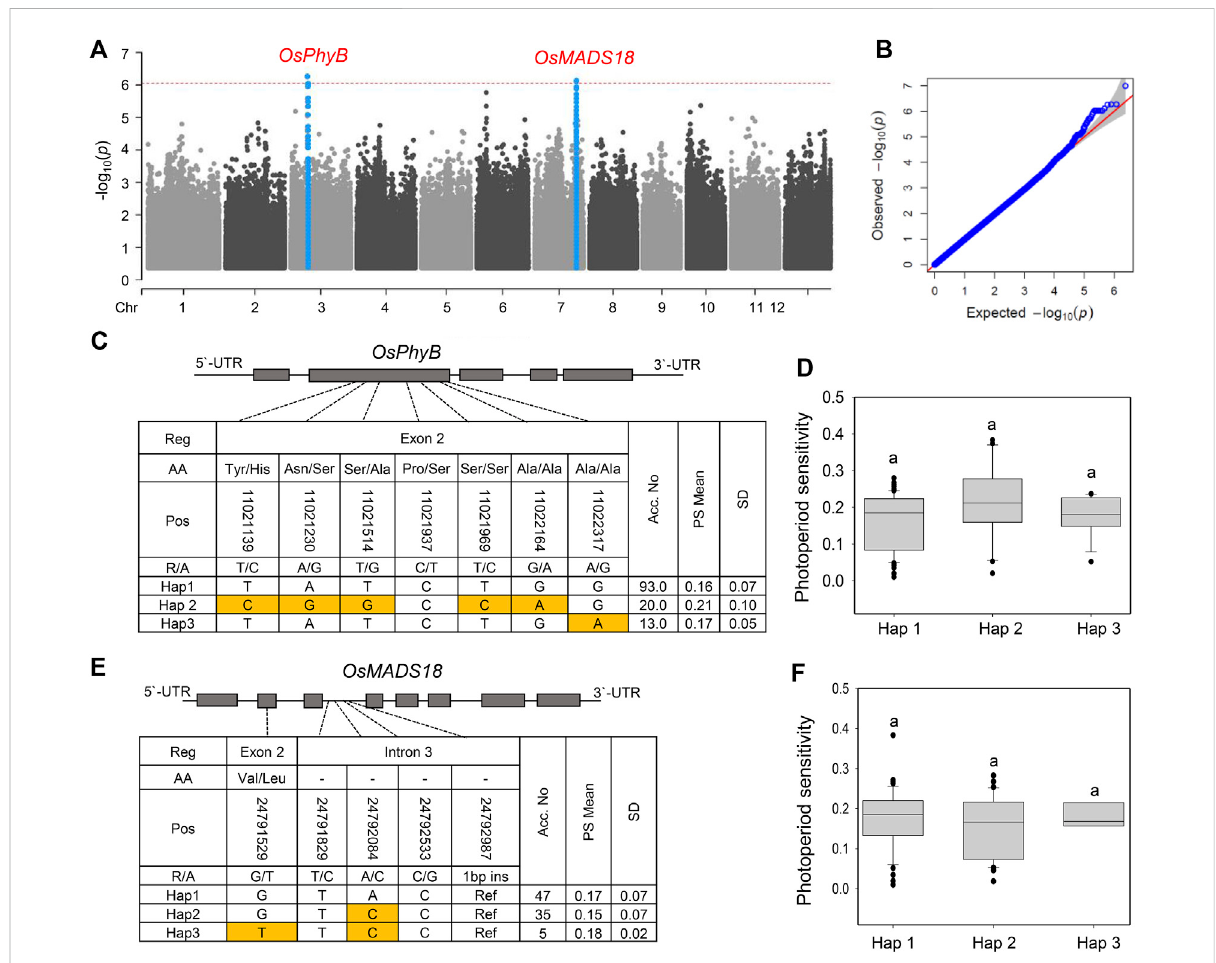
FIGURE 5 GWAS and haplotype analysis for photoperiod sensitivity. Manhattan. (A) and Q-Q plot (B) for a GWAS of photoperiod sensitivity in NK rice. For Q-Q plots, the horizontal and vertical axes represent the expected -log 10 ( p ) and observed -log 10 ( p ) of each SNP, respectively. The SNPs with p -values that deviated from the linear indicate reasonable positives. (C) OsPhyB haplotypes in CDS regions with SNPs. (D) Phenotypic variation of OsPhyB haplotypes. (E) Genestructureandhaplotypeanalysisof OsMADS18 . (F) Phenotypicvariationof OsMADS18 haplotypes.Differentletters indicate signi fi cant differences according to Duncan ’ s multiple range test ( p <